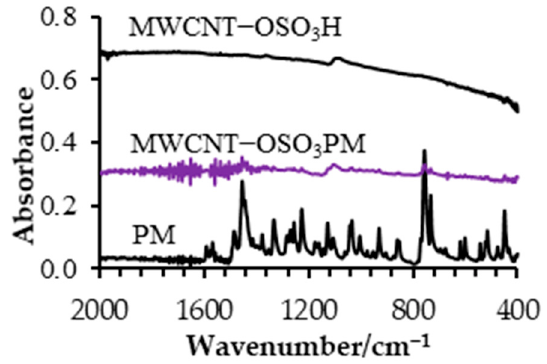
Figure 1. ATR − FTIR spectra of MWCNT − OSO 3 H, PM, and MWCNT − OSO 3